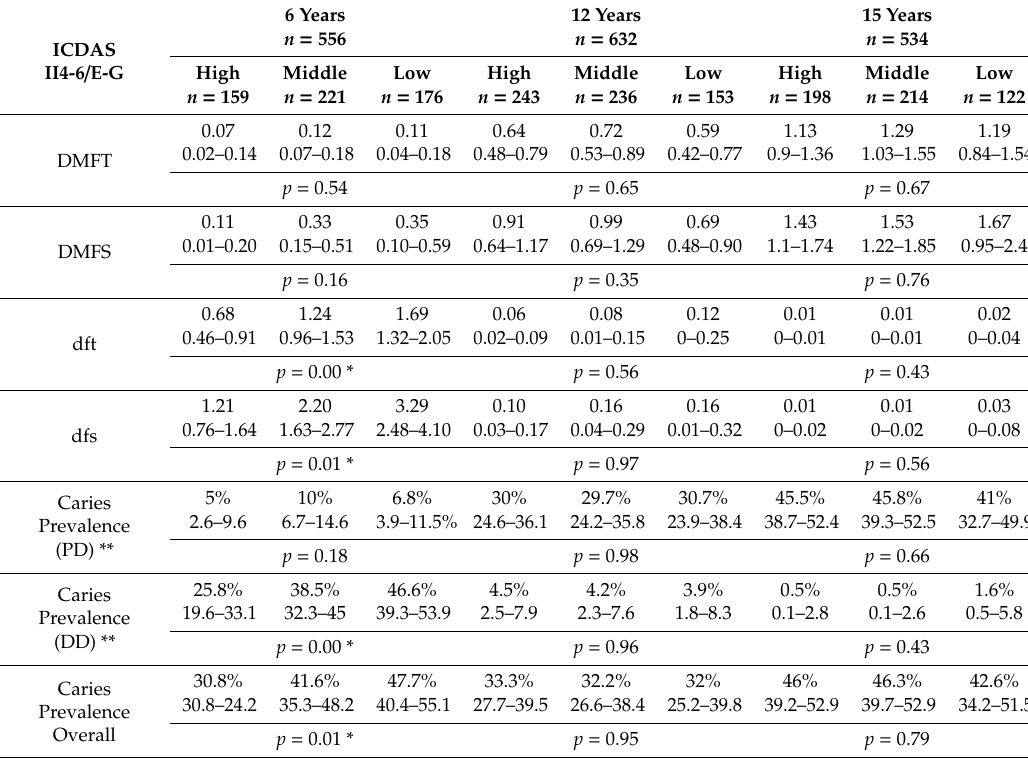
Table 4. Main indicators of caries according to ICDAS II 4-6 / E-G criteria, by age cohort and socioeconomic